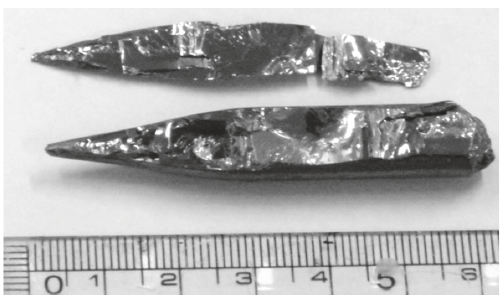
Figure 3: Cleaved SbI 3 crystals.